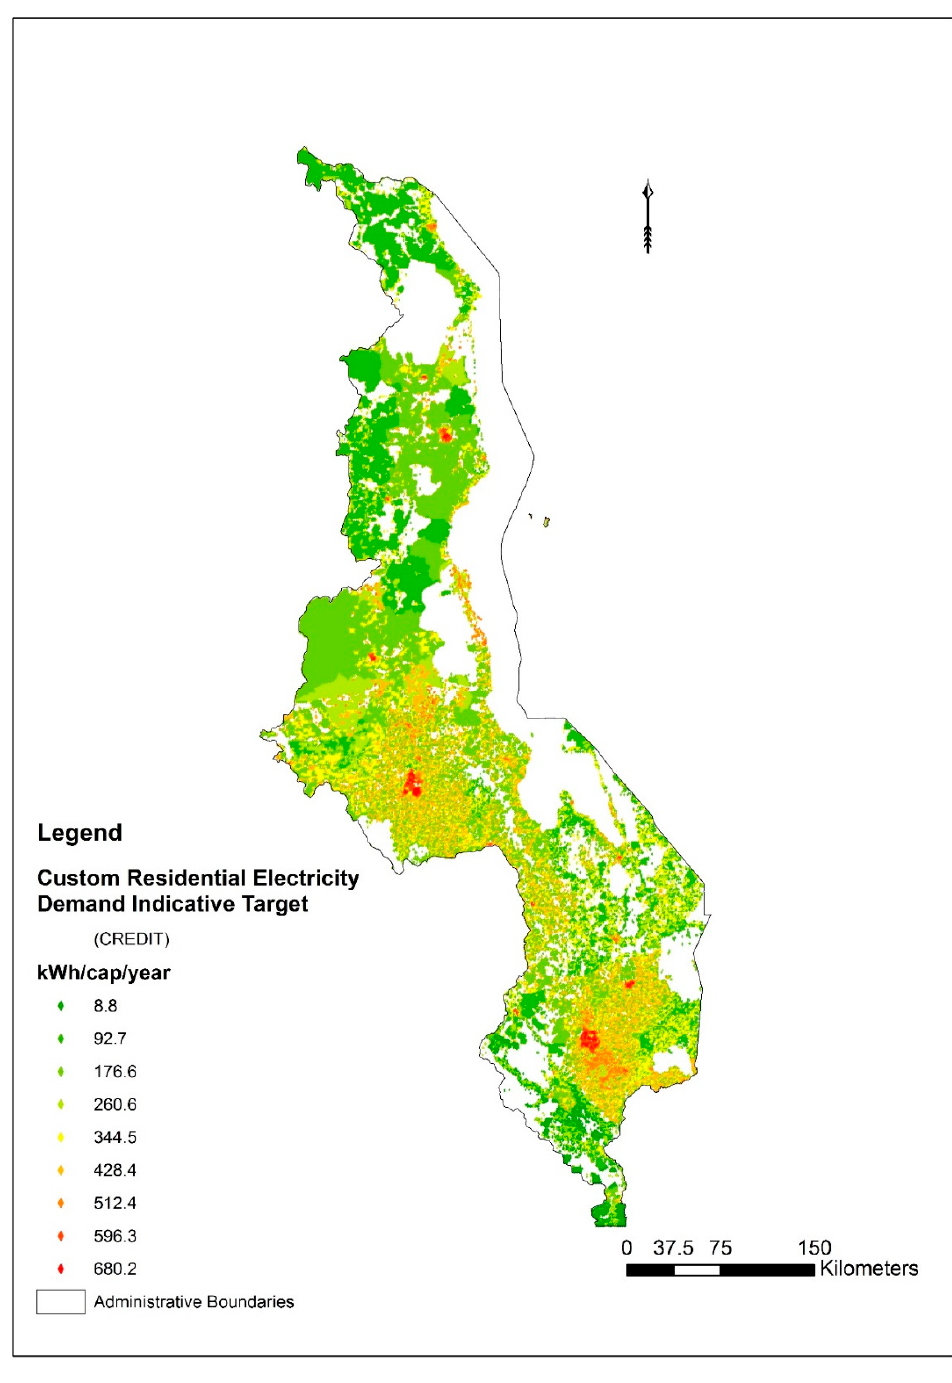
Figure A7. Customized layer indicating electricity demand target levels (in kWh/capita/year) over Malawi, based on openly available poverty and GDP maps.